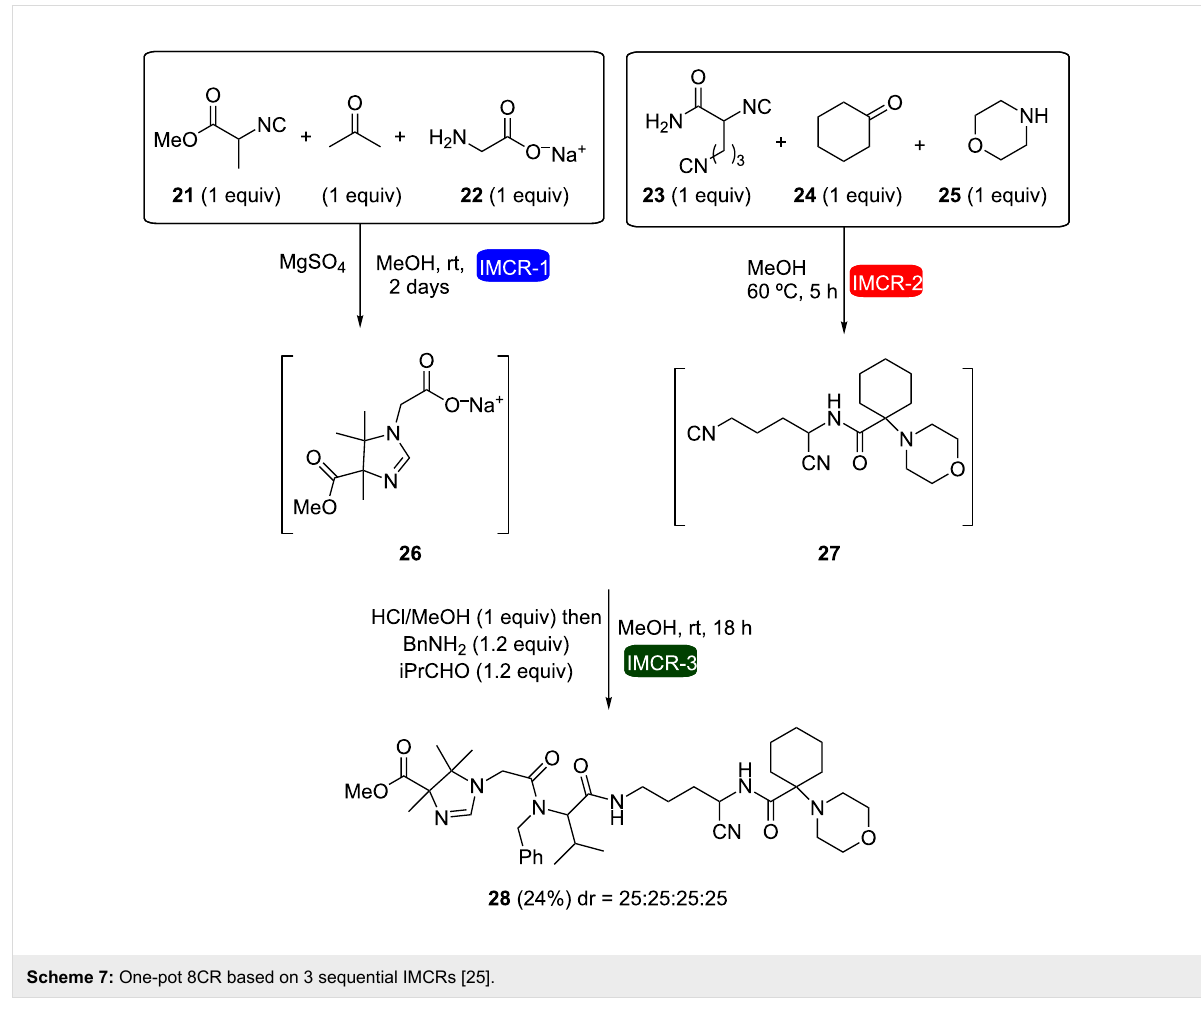
Scheme 7: One-pot 8CR based on 3 sequential IMCRs [25].